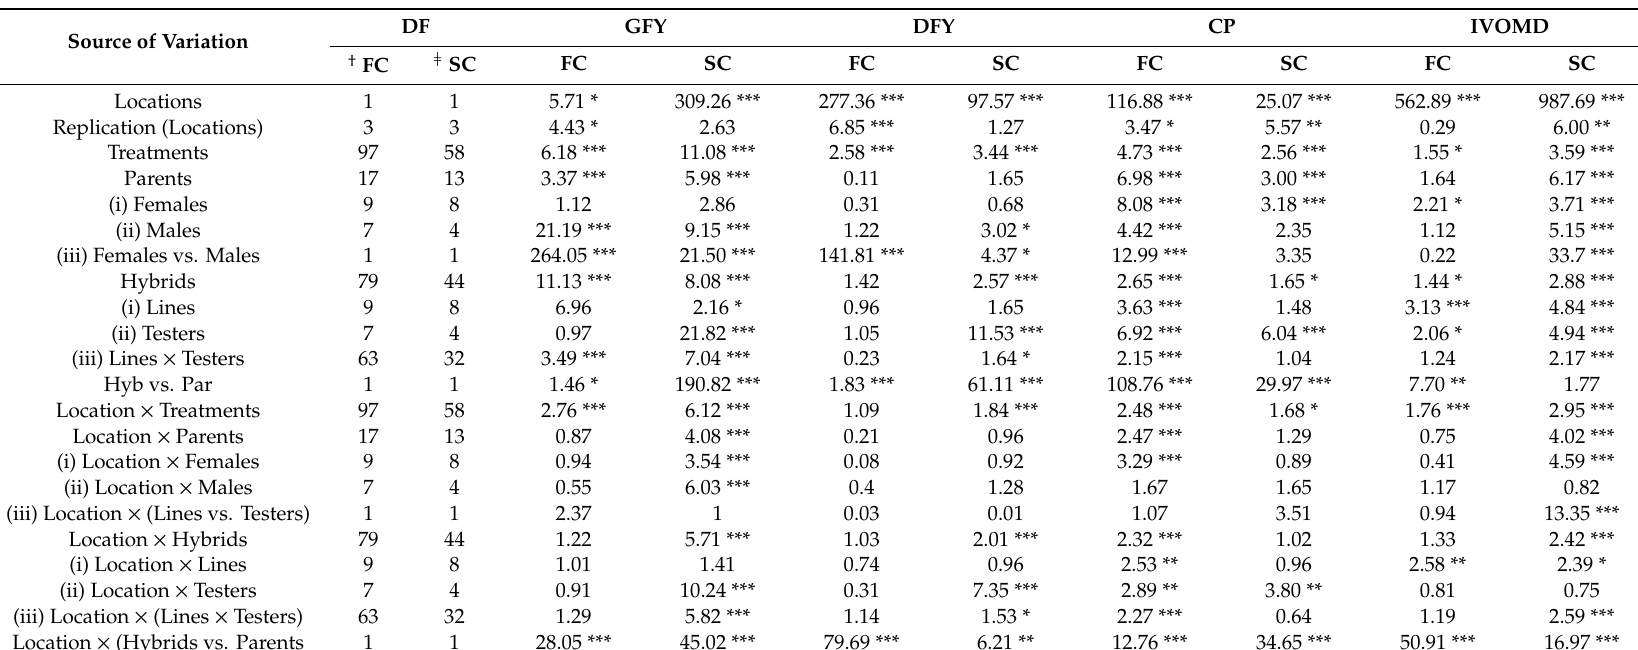
Table 4. Analysis of variance for combining ability for forage related morphological and biochemical traits at first and second cut, evaluated in hybrids and parental trial at two locations in summer season of